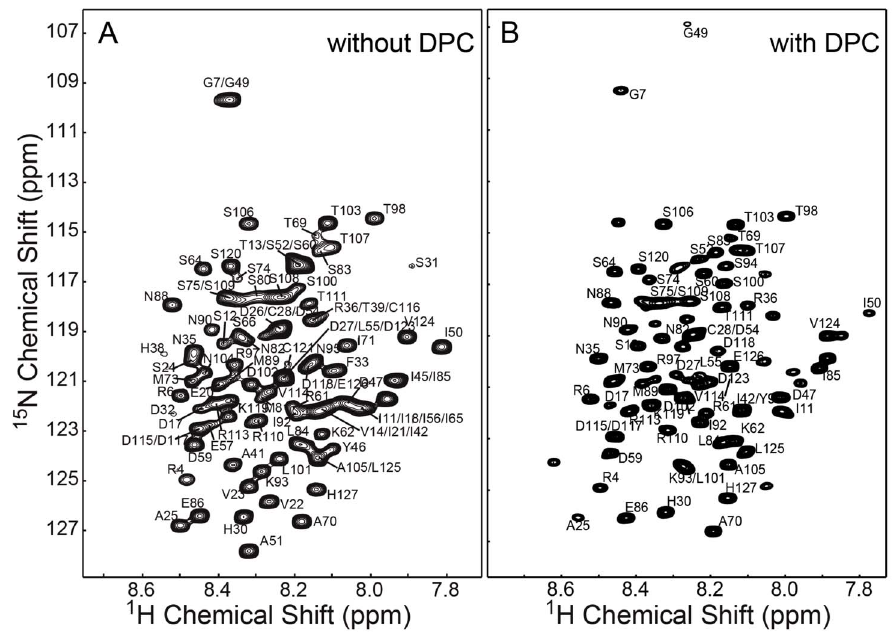
Figure 3. 1 H- 15 N HSQC spectra showing the crosspeak assignments of MPS-1(134–256) in the absence or presence of DPC micelles. (A) Identifies of a total of 90 of 111 non-proline amino acids were based on (N)H, N, C a , C b and CO correlations were made for MPS-1(134–256); (B) In contrast, 66 amino acids were assigned for for MPS-1(134–256) in DPC micelles.